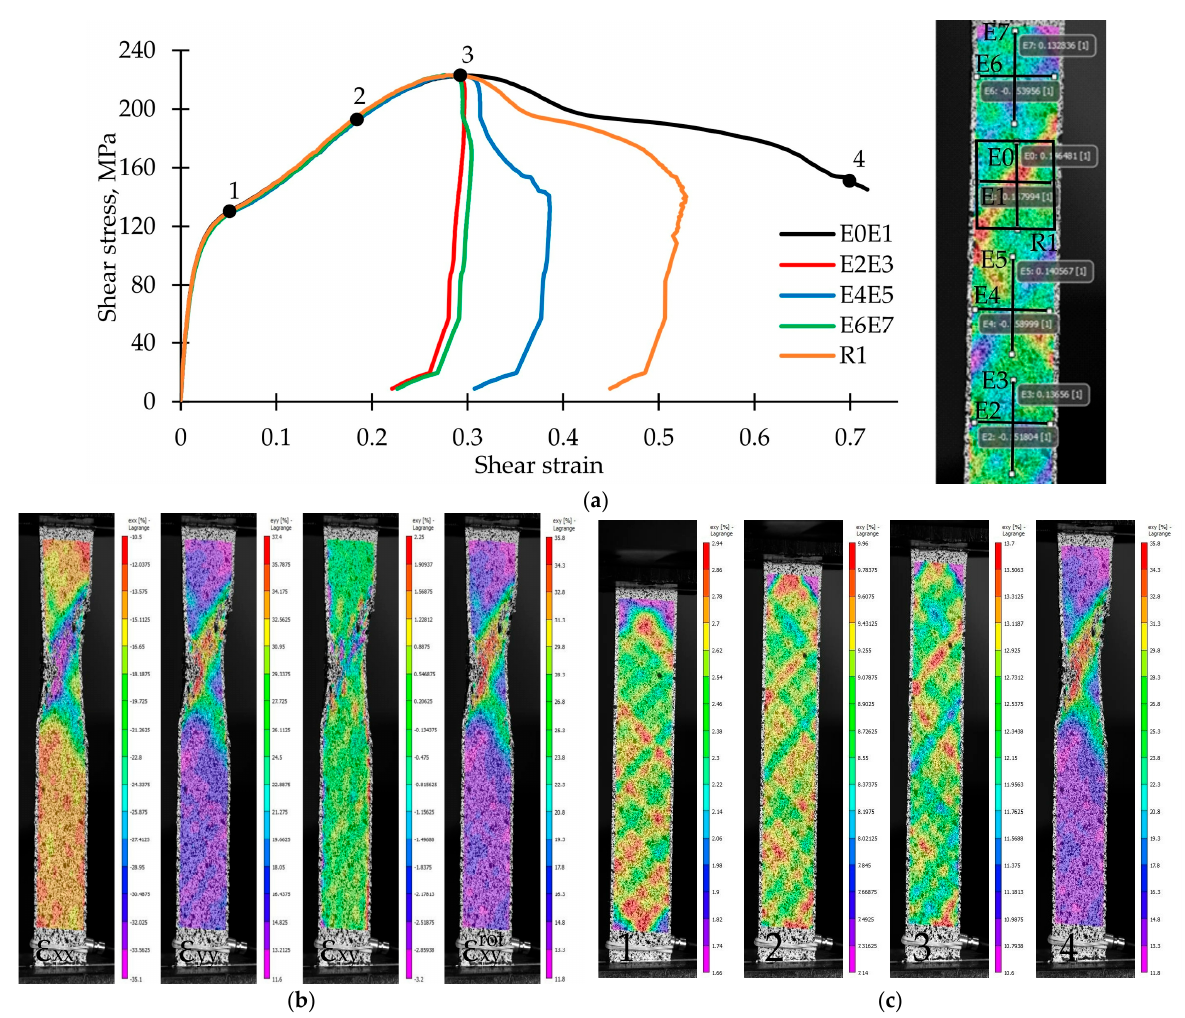
Figure 3. Choice of shear strain calculation method: ( a ) Stress–strain curves that are built following various methods (on the left); “virtual extensometers” location on the sample surface (on the right); ( b ) strains fields for point 4 on the stress–strain curve; ( c ) shear strains field evolution in the rotated coordinate system for the points 1–4 on the stress–strain curve.